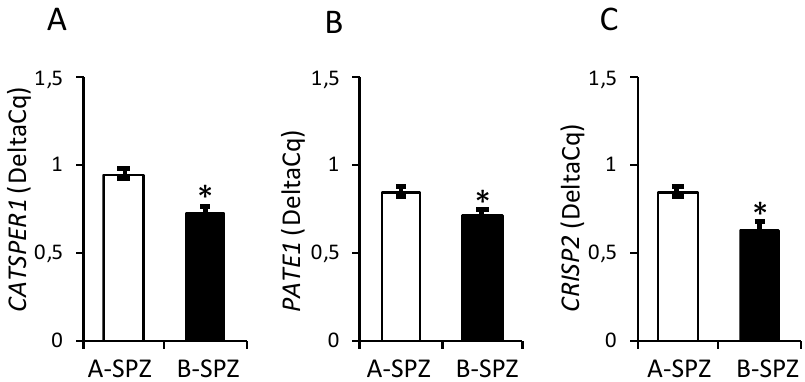
Figure 1. Expression of CATSPER1 , PATE1 and CRISP2 in Normozoospermic Sperm. ( A – C ) Differential expression analysis of mRNAs between A-spermatozoa and B-spermatozoa (A-SPZ; B-SPZ) collected from normozoospermic volunteers by qRT-PCR. ( A ) CATSPER1 , ( B ) PATE1 and ( C ) CRISP2 were normalized by using GAPDH as the reference gene and data are expressed as normalized quantification cycle for PCR (Delta-Cq). All data are reported as mean value ± S.E.M; *: p < 0.05.